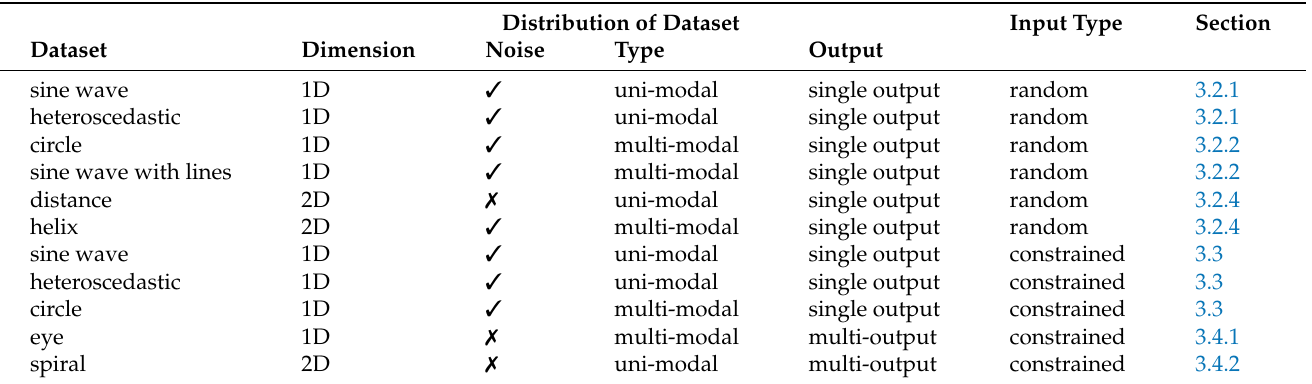
Table 1. Properties of the synthetic